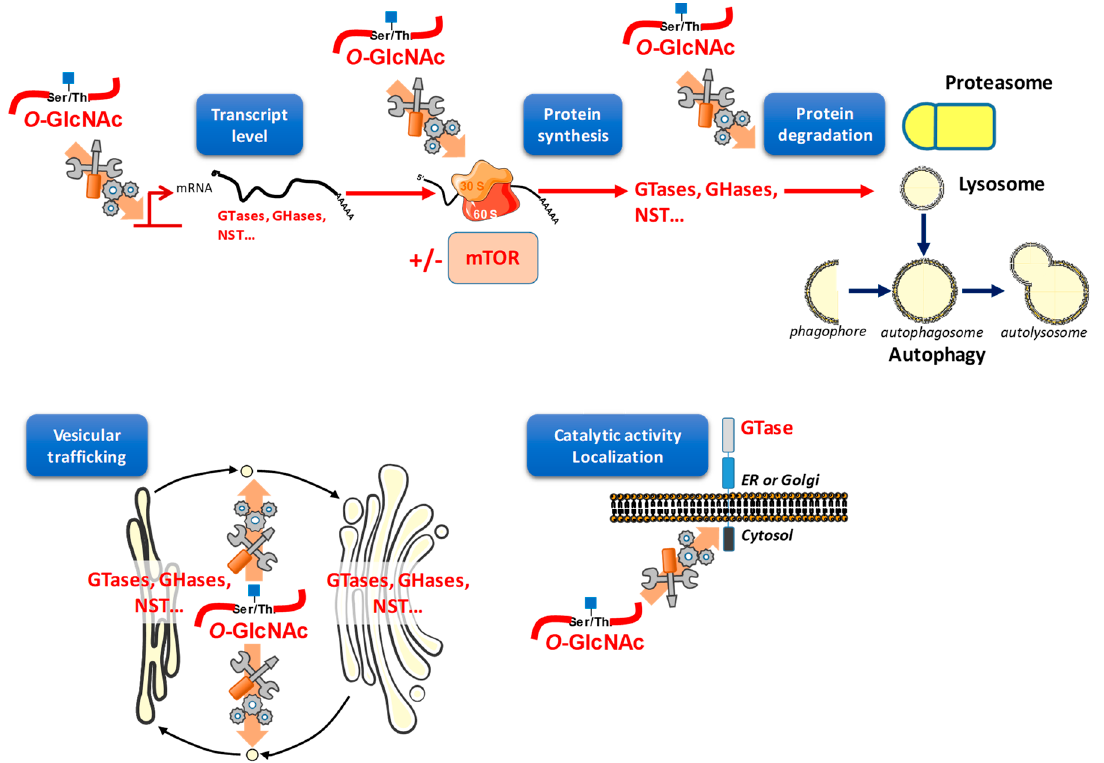
Figure 4. O -GlcNAcylation is a regulator of the most fundamental biological processes, such as protein fate, traffic, localization, and activity. Many studies report the functions played by O -GlcNAcylation in transcription, translation (especially in a mTOR-dependent manner), and protein degradation. The different patterns of glycosylation are likely to be regulated by these fundamental processes. Via vesicular trafficking, O -GlcNAcylation could also coordinate GTases, GHases, NSTs, or any other actors involved in glycosylation distribution, by targeting these actors to specific organelles. Lastly, since many glycosylation enzymes that are resident in the ER and the Golgi apparatus are integral proteins, their cytoplasmic tail might be a platform of interaction with OGT.